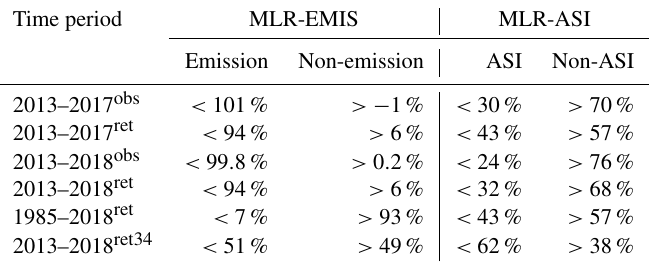
Table 5. Contributions of emissions and ASI to the PM 2 . 5 trends in BTH.